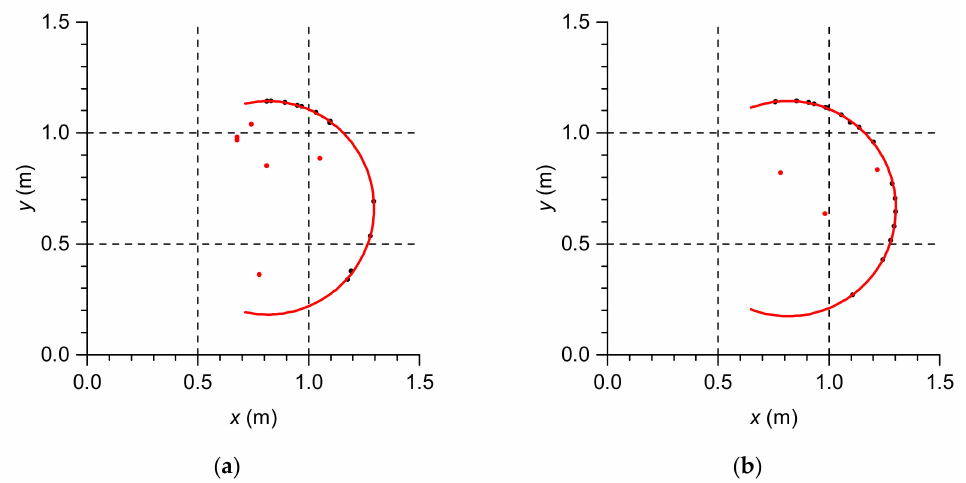
Figure 3. Graphs of measuring points obtained from total station reflectorless (RL) measurement at measurement level ( a ) 0.00 m and ( b ) 1.18 m.